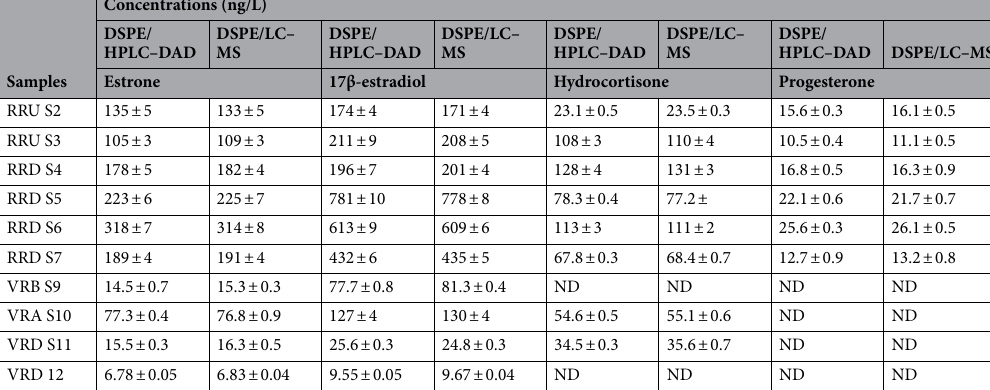
Table 4. Application to real water samples, n = 3 (average ± std